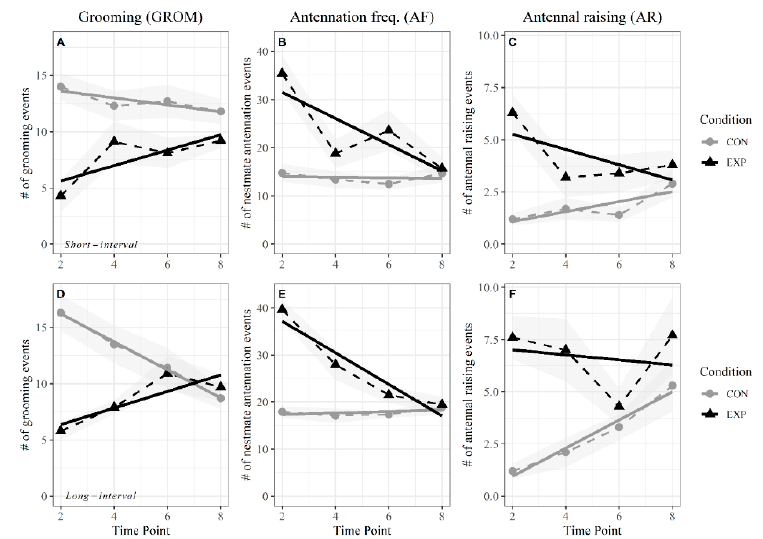
Figure 4. Patterns of reducing alarm response. Behavioral responses to repeated exposure of alarm pheromone over short ( A – C ) and long ( D – F ) intervals. Solid lines are linear models of the change in each behavior over the experimental duration. Dashed lines represent mean behavior surrounded by a shaded standard error ribbon. Only stimulus timepoints are included in these graphs. CON = ambient air, EXP = sender chamber air. For both the short- and long-interval experiments, n = 10 replicate groups, each with 25